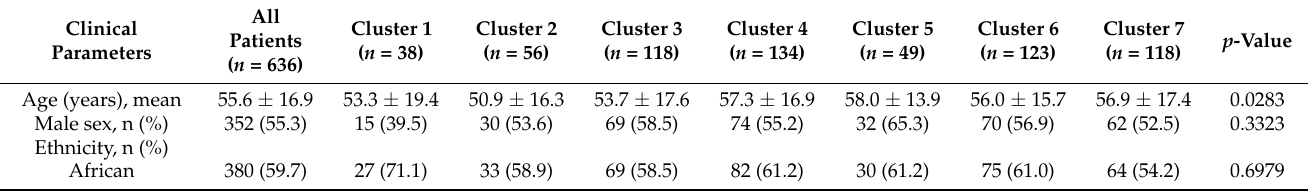
Table 6. Baseline demographic and clinical characteristics of the study patients stratified according to clusters identified by the Gaussian mixture model using the dataset without the left ventricular ejection parameter.